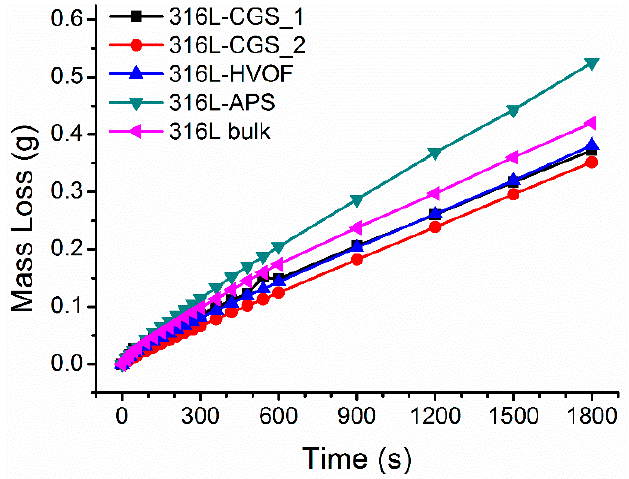
Figure 12. Results of rubber wheel testing for 316L coatings and bulk.